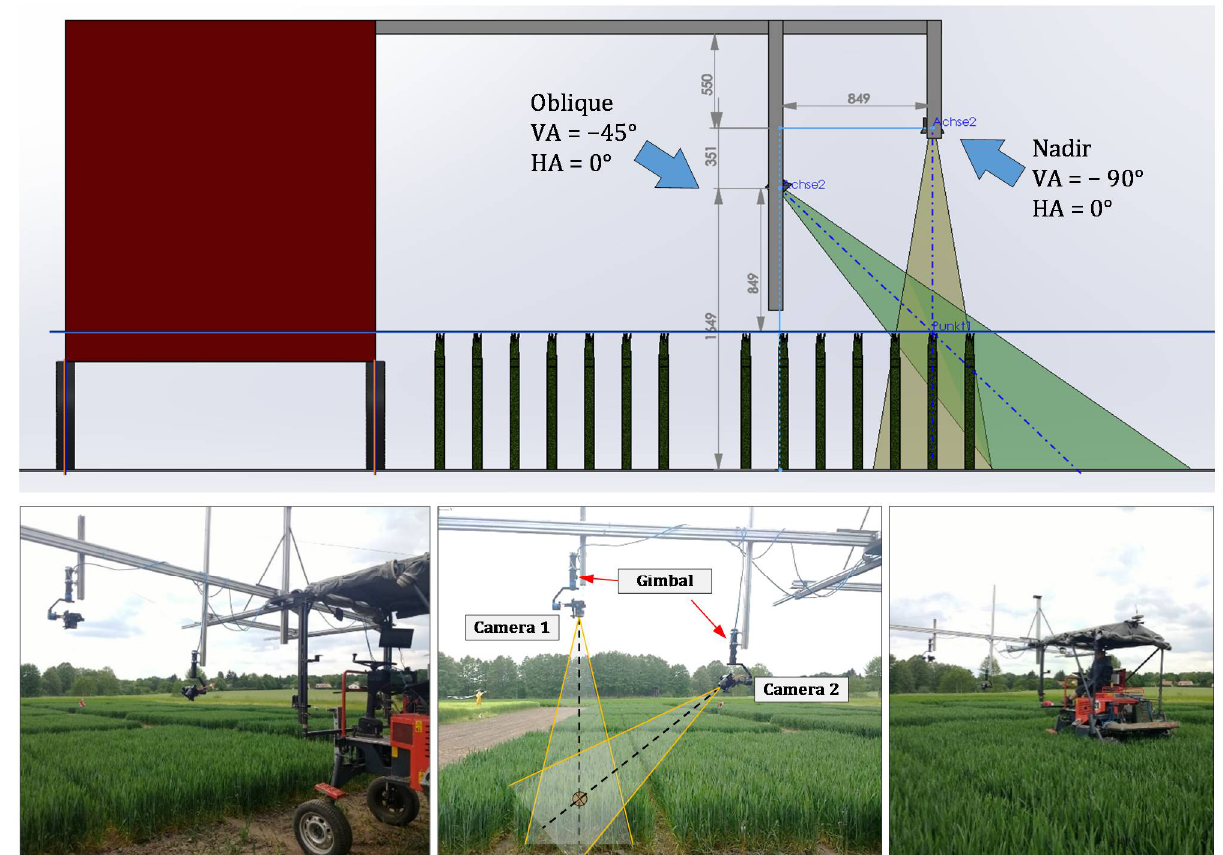
Figure 4. Field experiment setup showing schematic side view of the platform and the position of the vertical poles and the height of the gimbal platform ( top image ), and the actual camera arrangement on the sample plot area ( bottom images ).